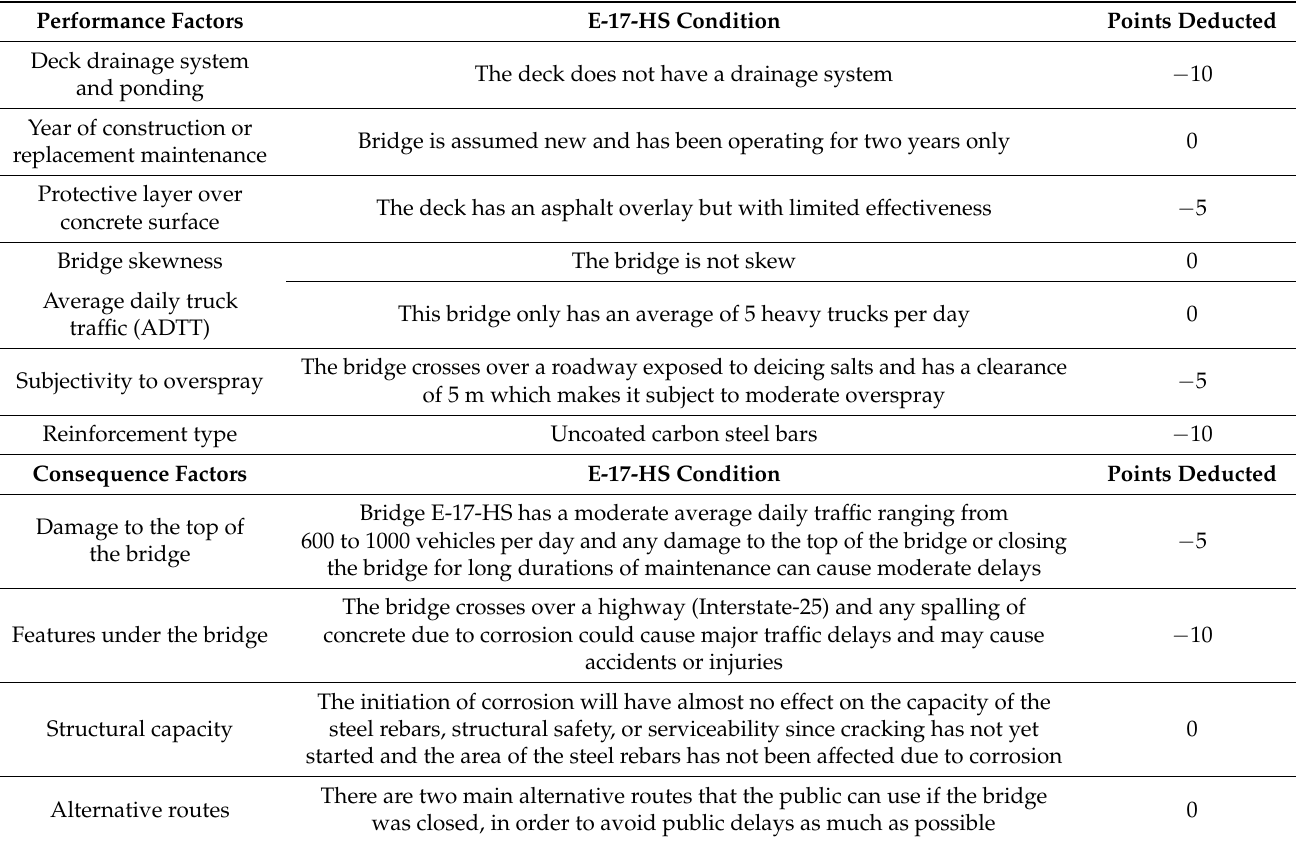
Table 5. Points that will be deducted from initial score based on the P&C factors.